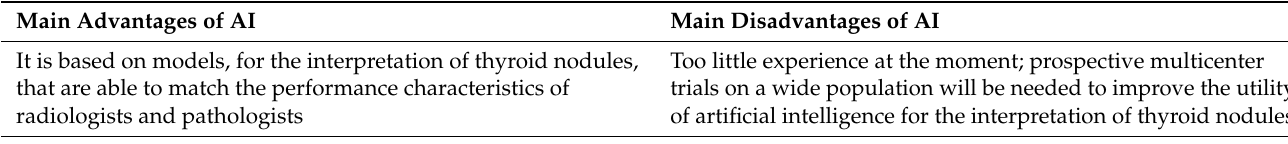
Table 2. Advantages and disadvantages of artificial intelligence over conventional